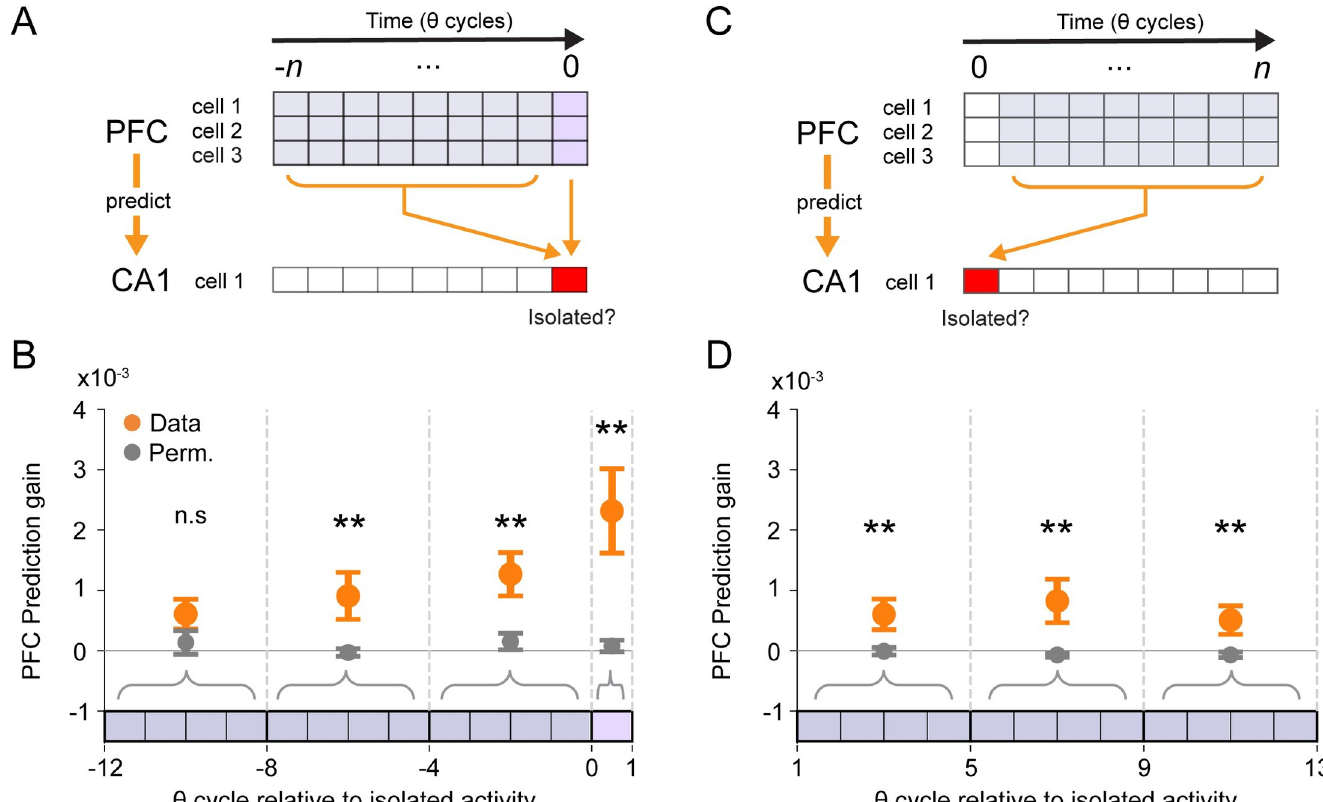
Fig 7. PFC activity predicts the occurrence of hippocampal isolated spiking. (A) PFC activity leading up to isolated spiking is used to predict the future occurrence of isolated spiking in one CA1 place cell. (B) Prediction gain (mean ± SEM) of GLMs where PFC spiking activity is used to predict isolated spiking in the upcoming CA1 theta cycle ( n = 158). Pairwise permutation test ( �� p < 0.05) with multiple comparison correction: p = 0.079, p = 0.0027, p = 0.0006, and p < 0.0002 for each group, respectively. (C) PFC activity after isolated spiking is used to predict the previous occurrence of isolated spiking in one CA1 place cell. (D) Prediction gain (mean ± SEM) of GLMs where PFC spiking activity is used to predict whether CA1 isolated activity had occurred ( n = 162). Pairwise permutation test ( �� p < 0.05) with multiple comparison correction: p = 0.0071, p = 0.0002, and p = 0.0053 for each group, respectively. GLM, generalized linear model; PFC, prefrontal